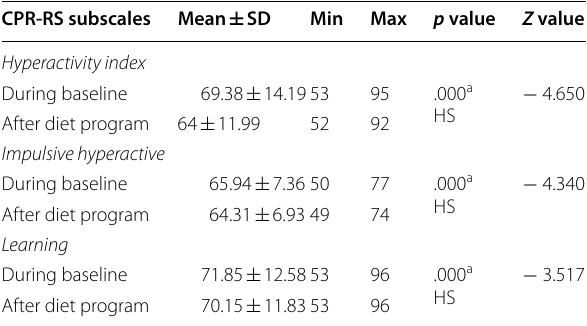
Table 4 CPR scores during baseline and after diet